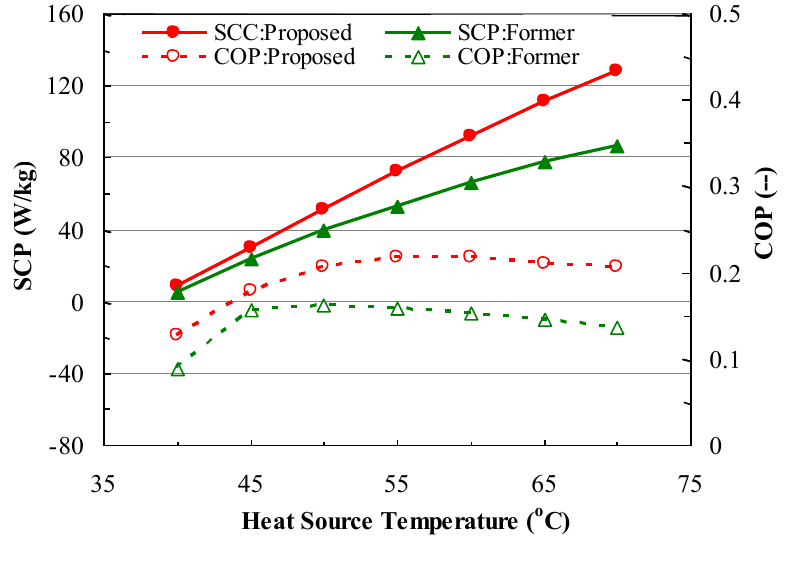
Figure 10. Comparison of optimal SCP and COP of proposed cycle with the former six-bed three-stage